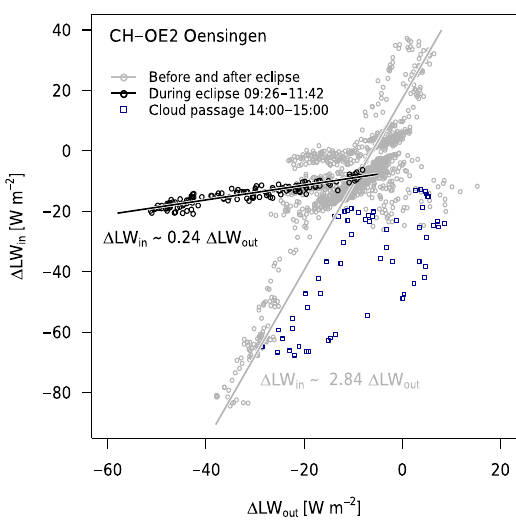
Figure 3. Long-wave back-radiation effect during the eclipse (black symbols and regression line) in comparison to conditions before and after the eclipse (gray symbols and regression line). The differences (cid:49) LW between 1min averages from the day before the eclipse and the same time during the day of the eclipse are shown ( (cid:49) LW in in relation to (cid:49) LW out using the regression approach (cid:49) LW x = LW x ( 20 March ) − LW x ( 19 March ) with x representing index in or out ). Measurements made during a period with cloud passage on 19 March 2015 (blue symbols) were excluded from